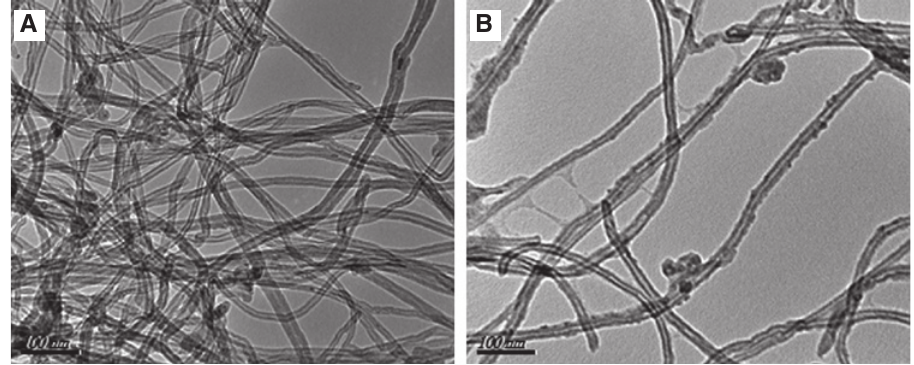
Figure 7: TEM images of (A) unmodified CNTs and (B) CNTs grafted with fluoropolymers.